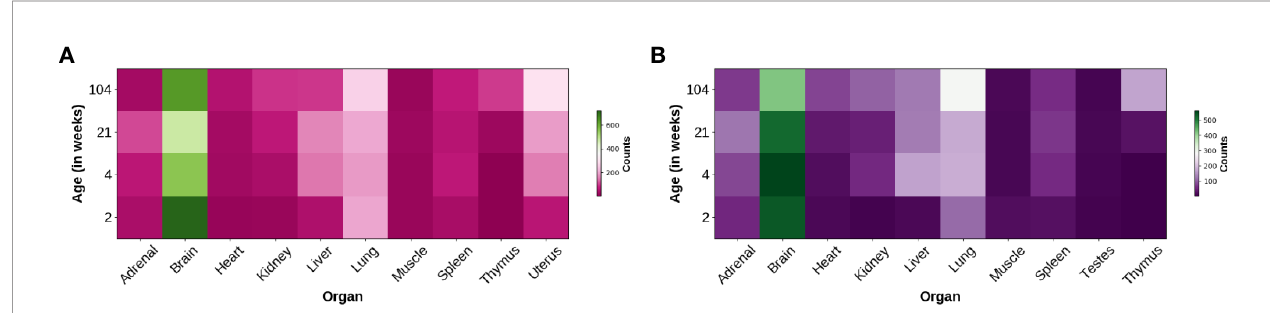
FIGURE 2 | Distribution of Trhde expression in multiple rat organs. Heatmaps show the heterogeneous Trhde expression, predominant in the brain. Other differences can be observed along multiple developmental stages and between females (A) and males (B) . Data were re fi ned from a database obtained from a transcriptomic pro fi ling study in Fischer 344 rats (Yu et al., 2014; Hicks et al.,